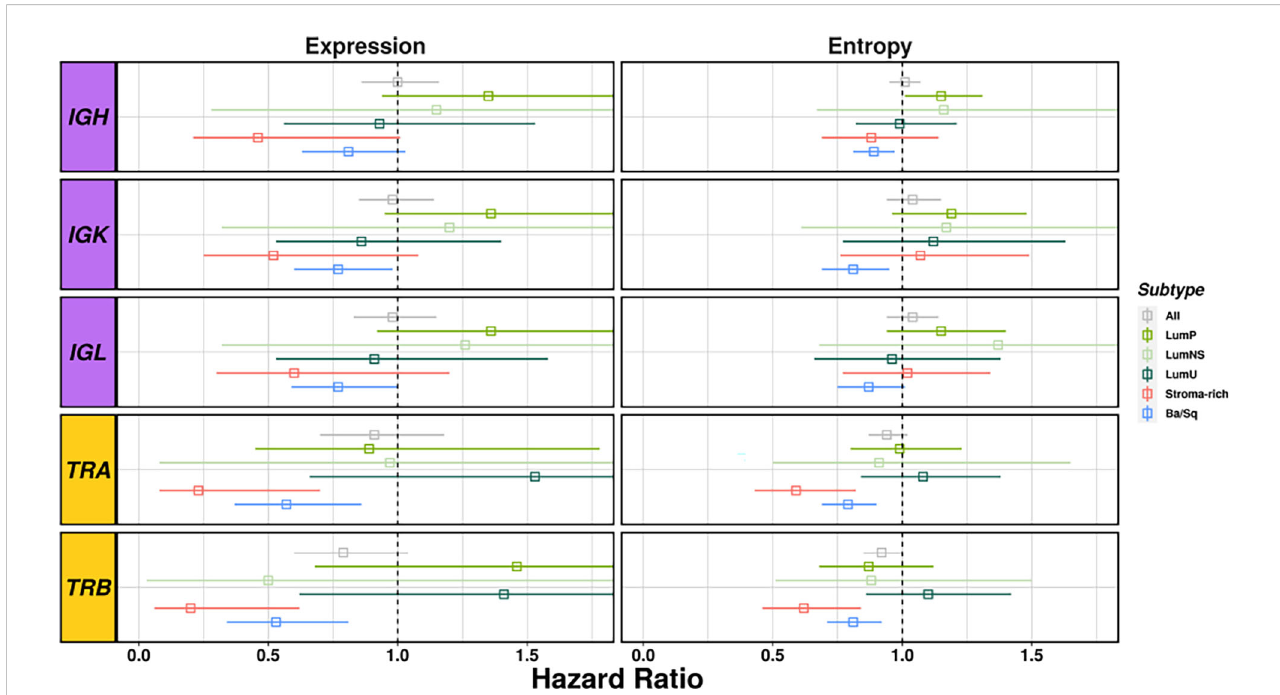
FIGURE 5 Survival analyses considering richness and diversity for all receptors results by subtype. BCR related results are plotted in purple and TCR in yellow. Each square represents the Hazard Ratio and its corresponding lines the 95%CI. The different colors indicates the different subtypes (see legend) and all cases together are display in